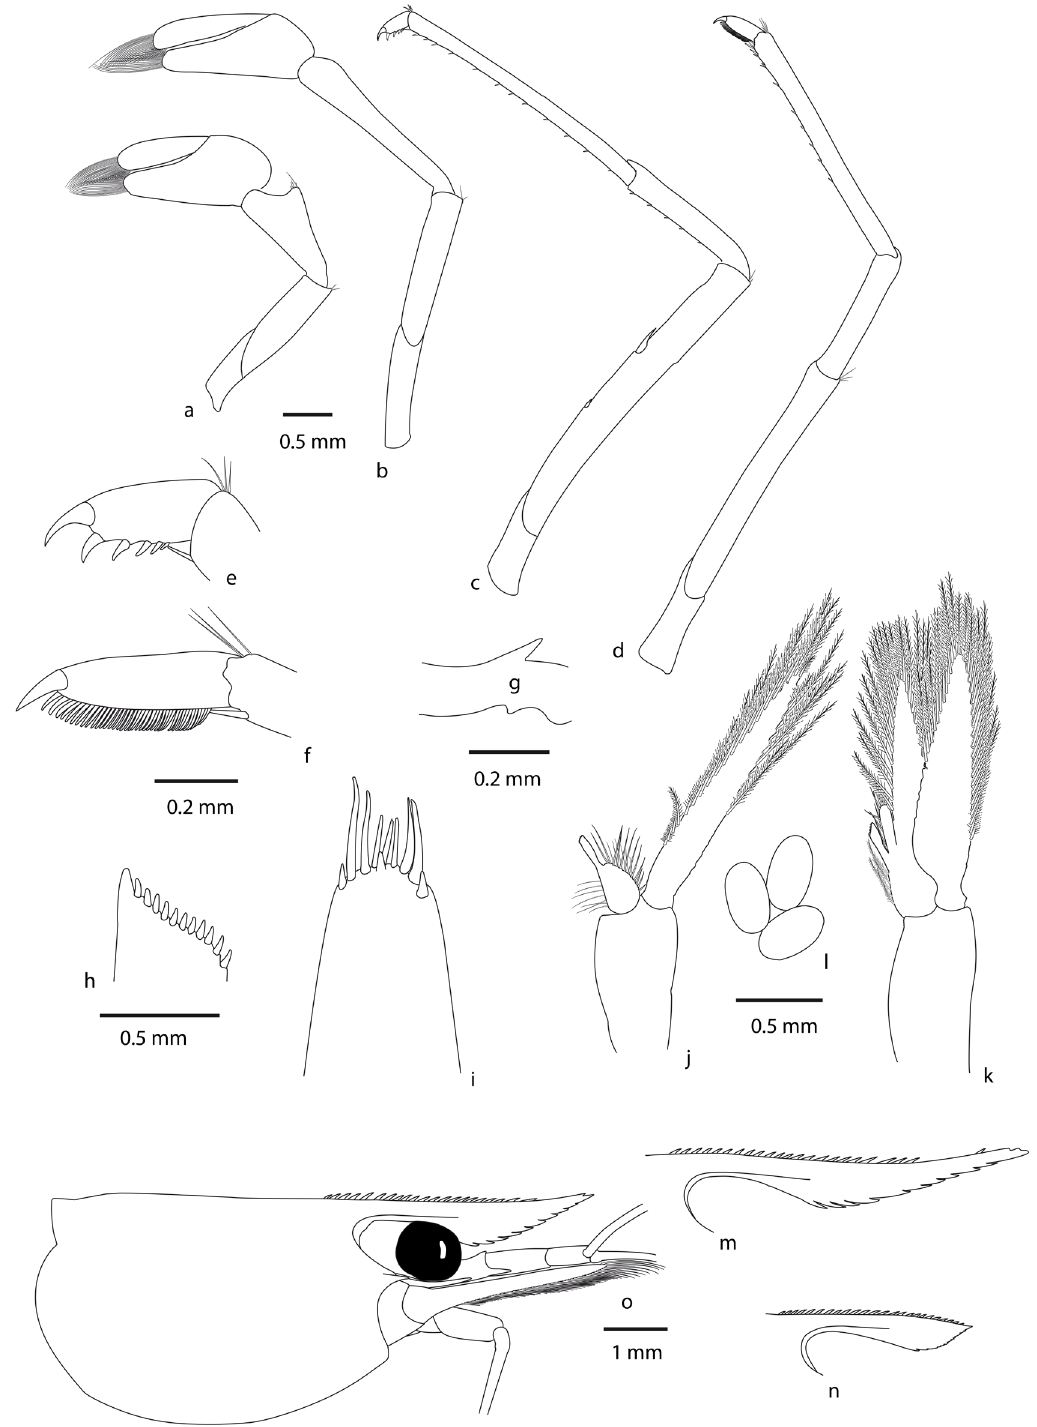
Fig. 6. Caridina choiseul sp. nov. a . First pereiopod. b . Second pereiopod. c . Third pereiopod. d . Fifth pereiopod. e . Dactylus of third pereiopod. f . Dactylus of fifth pereiopod. g . Pre-anal carina. h . Uropodal diaeresis. i . Telson. j . First male pleopod. k . Second male pleopod. l . Eggs. m–n. Rostrum variations. o . Cephalothorax. MNHN-IU-2014-20833 (a–g (top, with spine), h, l), MNHN-IU-2014-20836 (g (botom, without spine)), MNHN-IU-2014-20831 (i), MNHN-IU-2014-20829 (j–k), MNHN- IU-2014-20827 (m), MNHN-IU-2014-20837 (n) and MNHN-IU-2014-20826